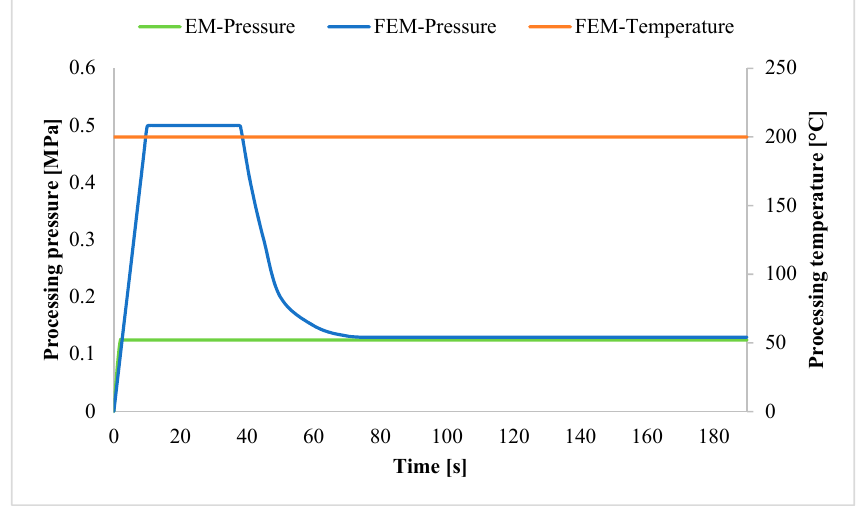
Figure 5. Processing values for pressure, temperature, and time determined with the FEM, compared with the pressure value for EM.